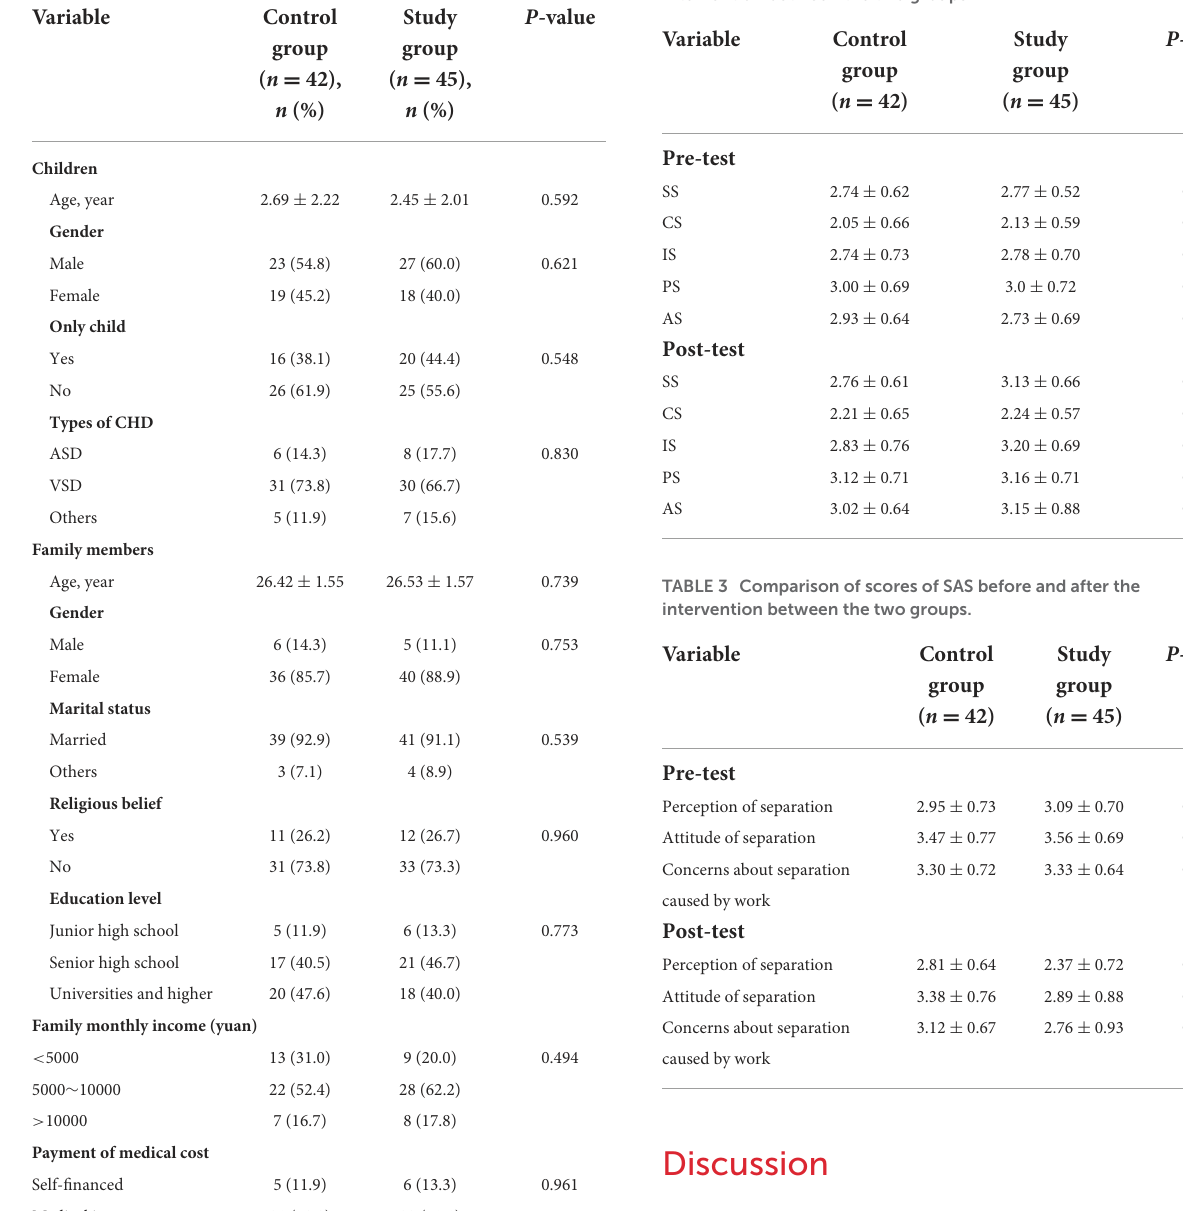
TABLE 1 Demographic and baseline characteristics of participants. TABLE 2 Comparison of scores of CCFNI before and after the intervention between the two groups.